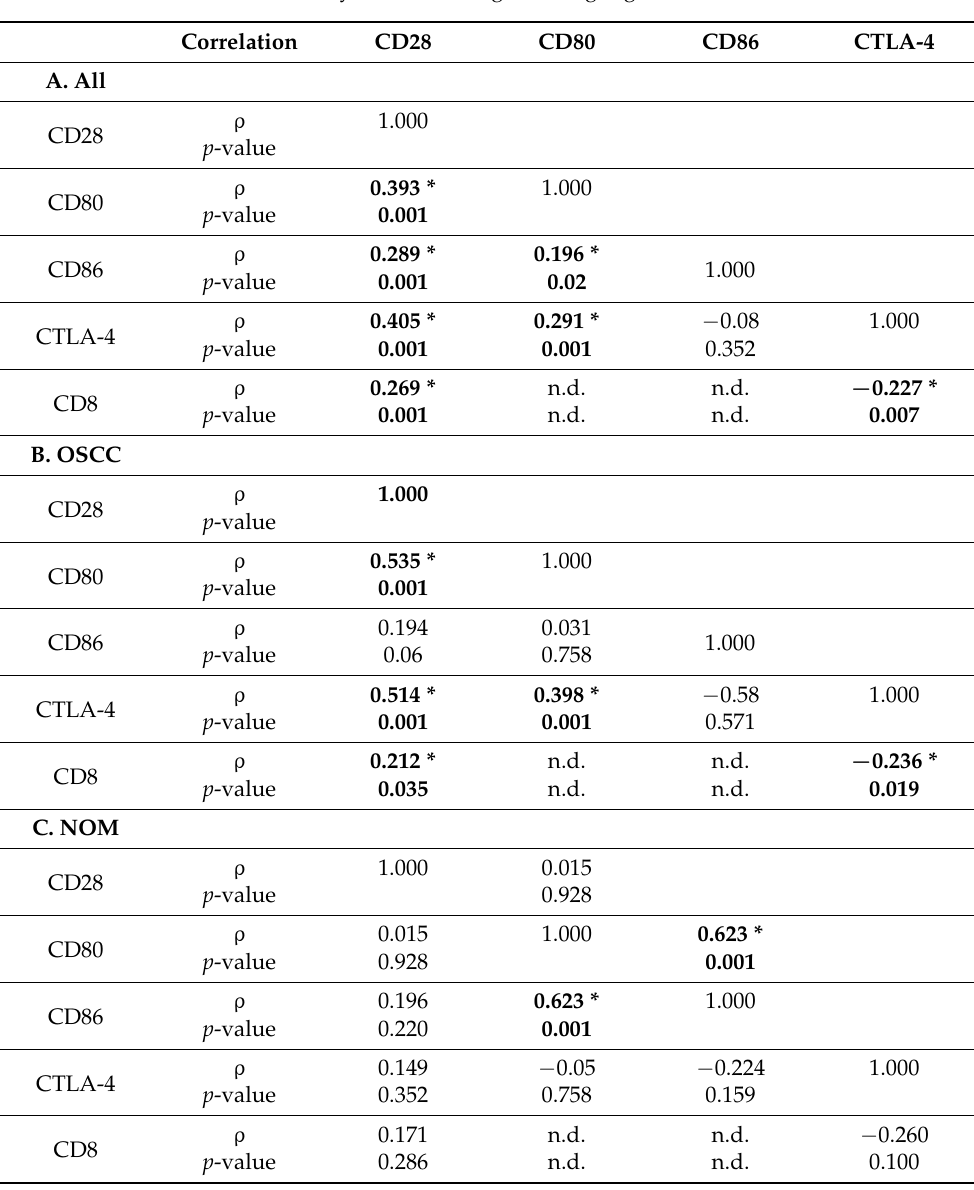
Table 7. Correlation of CD28, CD80, CD86 and CTLA-4 expression and correlation of CD8 with CD28 and CTLA-4. ( A ) All samples were used ( n = 139). Only ( B ) tumor ( n = 98) and ( C ) NOM ( n = 41) tissues were taken into account. The p -value was calculated by Spearman’s rho correlation. * The correlation is significant at the 0.01 level (2-tailed). ρ = Correlation coefficient; n = number of observations correlated. Statistically relevant changes are highlighted in